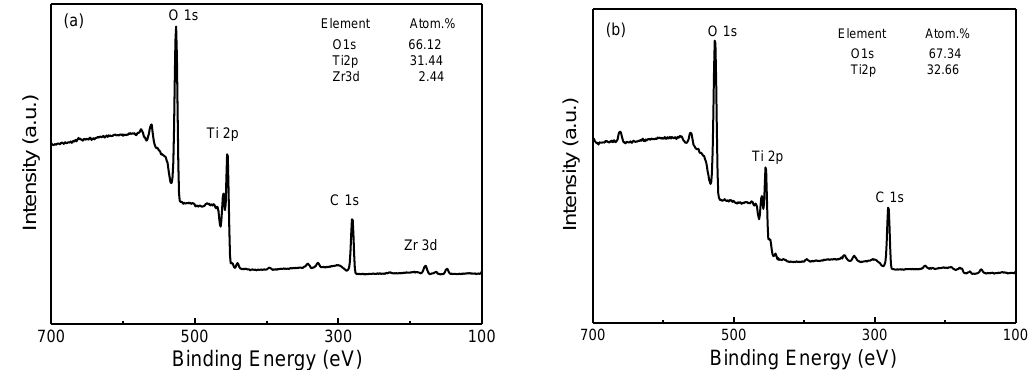
Figure 2. XPS spectra of TiO 2 nanotube array surface: ( a ) Zr 4+ doped; ( b ) undoped.